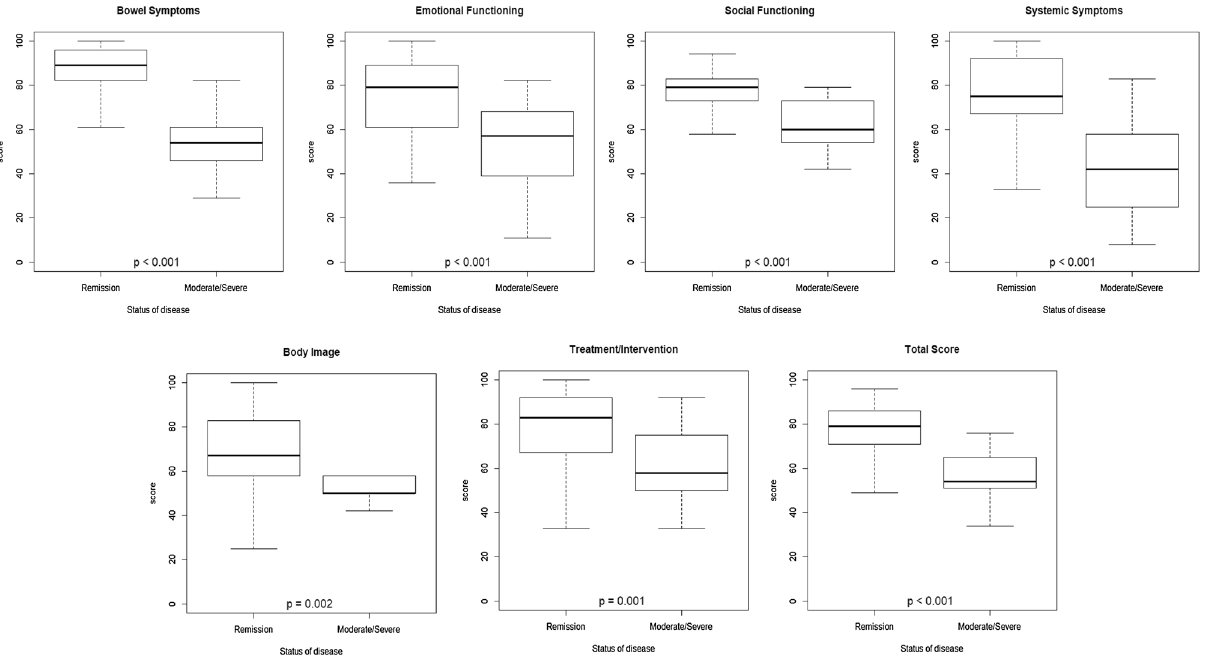
Figure 1. Discriminant validity for IMPACT-III questionnaire.